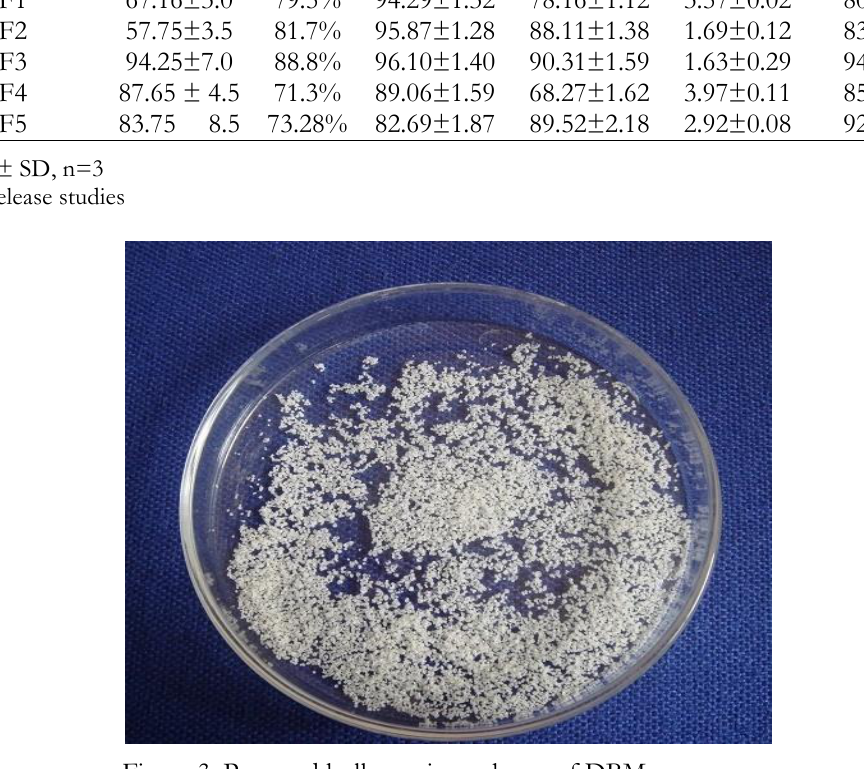
Figure 3: Prepared hollow microspheres of